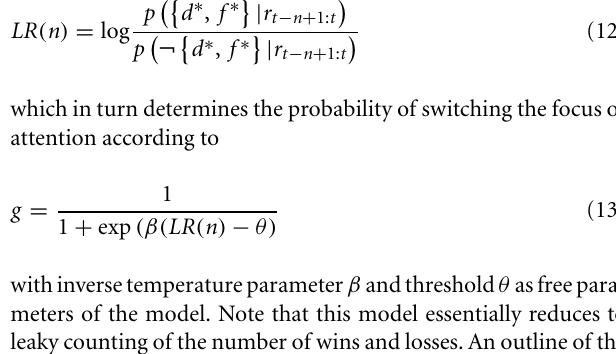
FIGURE 3 | Illustration of the Bayesian model in action with unsignaled change-points. Each square represents p ( d , f | D 1: t ), the distribution over correct dimension and feature, at a different trial, starting with trial 1 in the top left and finishing with trial 50 in the bottom